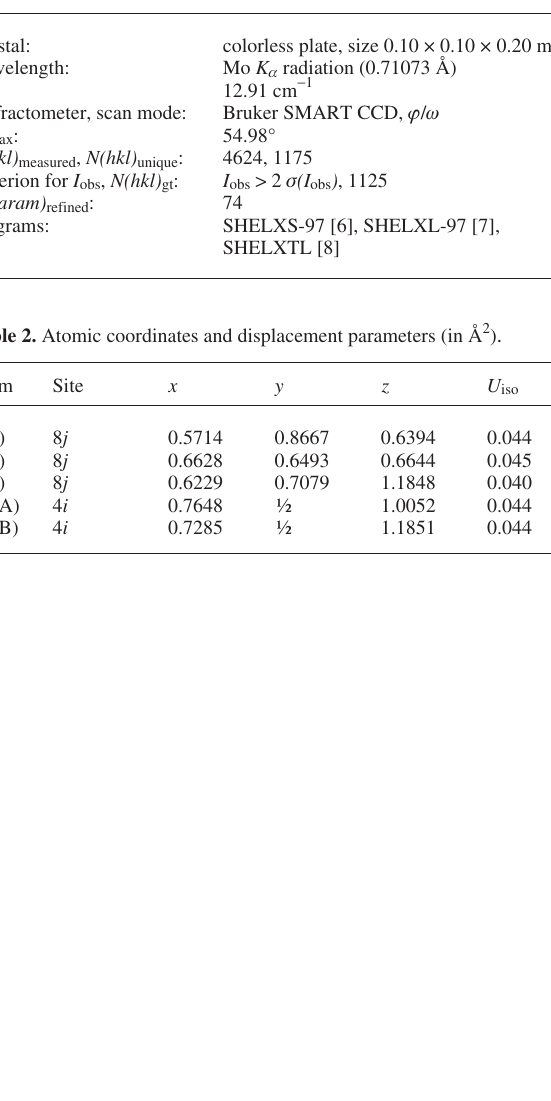
Table 1. Data collection and handling.